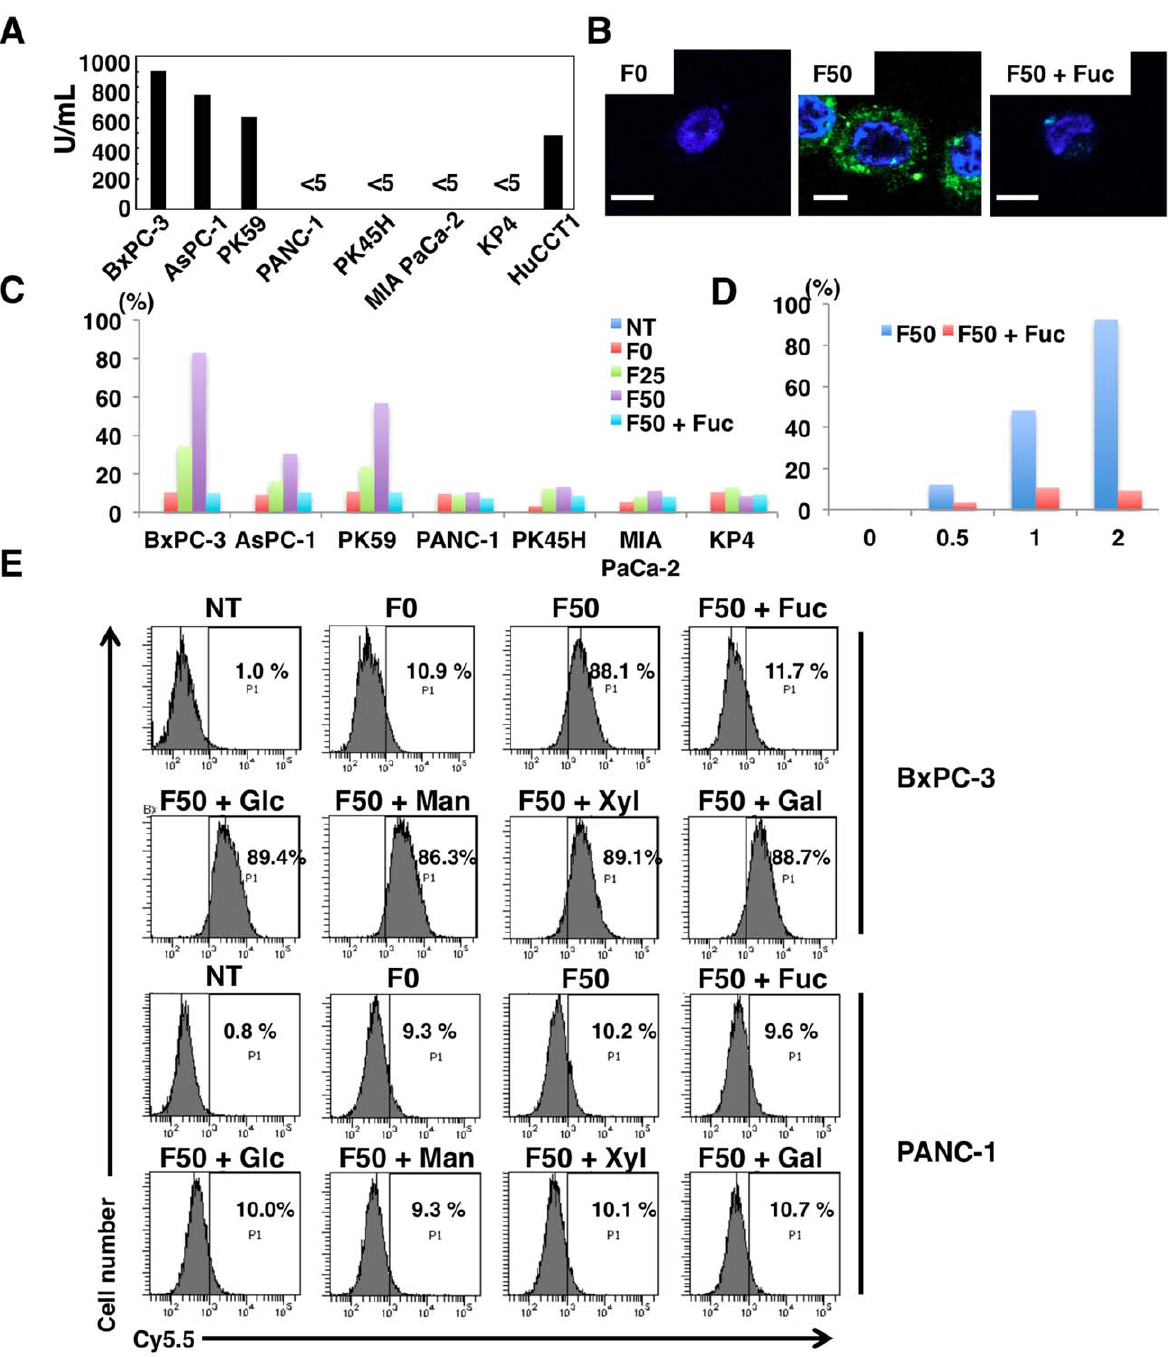
Figure 2. Transfer of Fuc-Liposome-Cy5.5 and -FAM into pancreatic cancer cells. ( A ) Concentration of CA19-9 secreted from different pancreatic cancer cell lines. Five million cells were incubated in serum-free medium for 48 hours and CA19-9 concentration was measured by ELISA. ( B) BxPC-3 cells were incubated with Fuc-Liposome-FAM in the presence or absence of excess L-fucose for 2 hours, then washed and observed by confocal laser microscopy. Scale bar, 10 m m. ( C ) Flow cytometric analysis of Fuc-Liposome-Cy5.5-treated cells. BxPC-3, PK59, AsPC-1 (CA19-9 producing cancer cells) and PANC-1, PK45H, MIA PaCa-2, KP4 (CA19-9 non-producing pancreatic cancer cells) cells were treated with Fuc-Liposome- Cy5.5 for 2 hours with or without excess L-fucose and were analyzed by flow cytometry. Cy5.5 positive cells were indicated. NT, no treatment: F0, F0- Liposome-Cy5.5: F25, F25-Liposome-Cy5.5: F50, F50-Liposome-Cy5.5: F50 + Fuc, excess L-Fucose. ( D ) HuCCT1 (CA19-9 producing) cells were incubated with Fuc-Liposome-Cy5.5 for indicated hours in the presence or absence of excess L-fucose, then washed twice with phosphate-buffered saline and analyzed by flow cytometry. ( E ) Effect of monosaccharides on introduction of Cy5.5 into pancreatic cancer cells by Fuc-Liposomes. Flow cytometric analysis of Fuc-Liposome-Cy5.5-treated cells. Cells were treated with Fuc-Liposome-Cy5.5 or Lipsome-Cy5.5 for 2 hours with or without excess monosaccharides and were analyzed by flow cytometry.